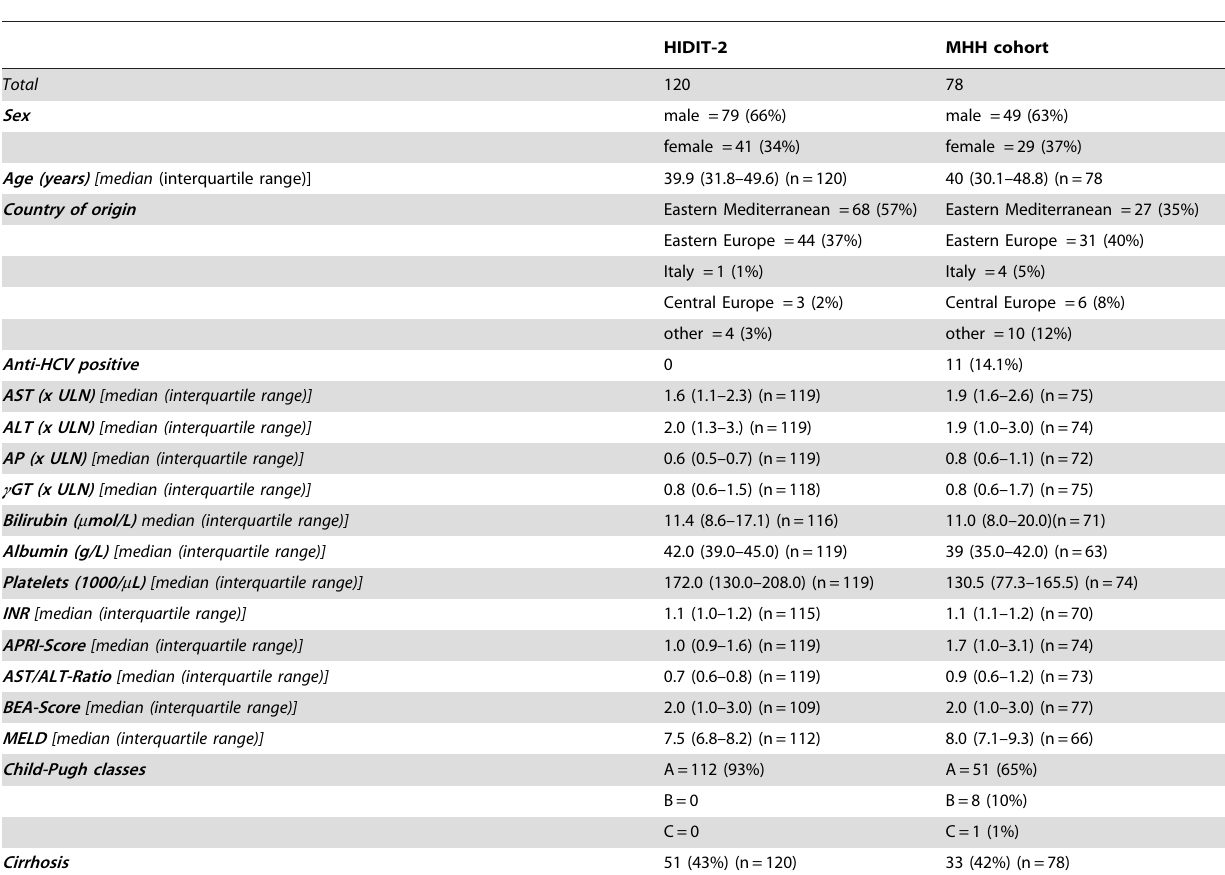
Table 1. Baseline